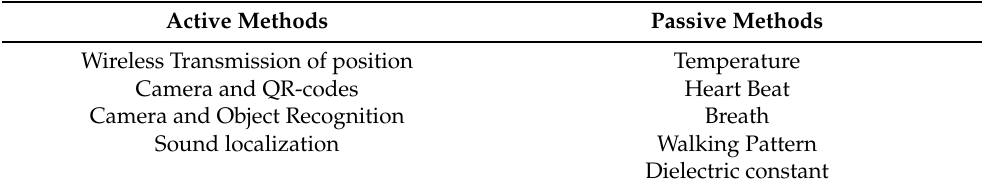
Table 2. Overview of active and passive methods for human–machine